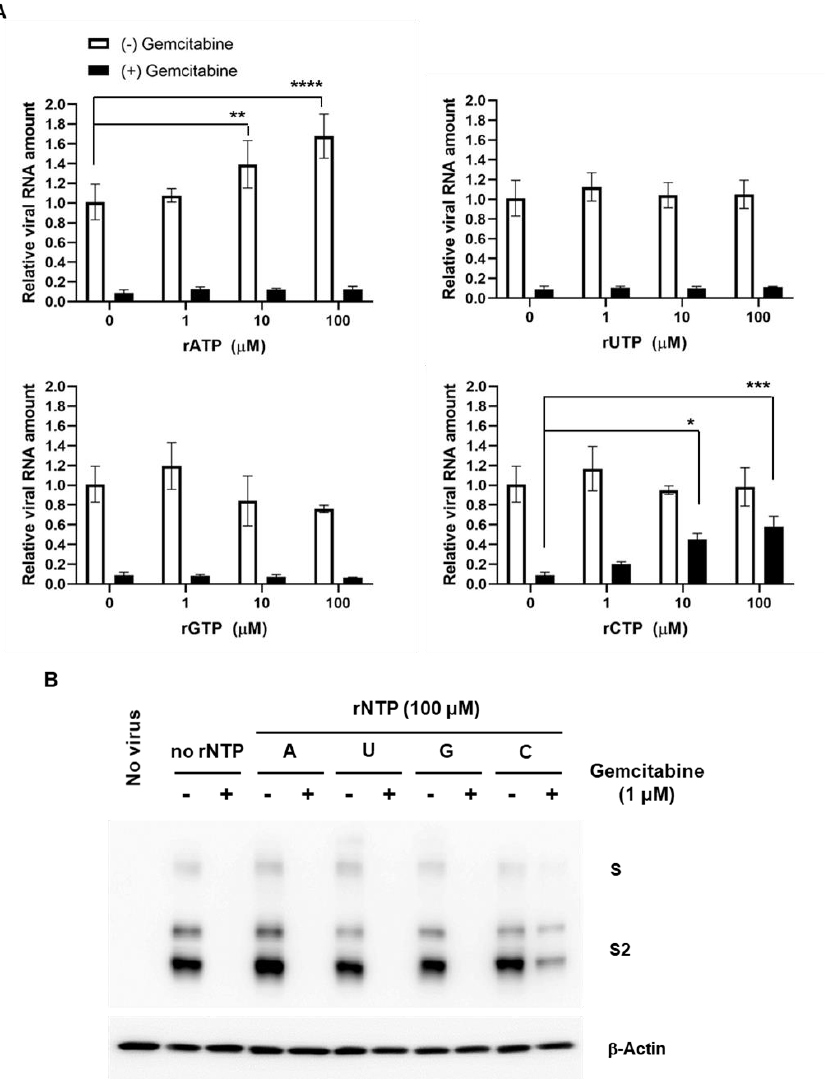
Figure 5. Competition assay between gemcitabine and each rNTP. ( A ) Real-time RT-PCR for measuring viral RNA amounts. Vero cells seeded in 6-well plates were infected with SARS-CoV-2 at an MOI of 0.001 and then treated with increasing concentrations of one of rNTPs including rATP, rUTP, rGTP and rCTP (1, 10, and 100 μM) in the absence (white bars) or presence of gemcitabine (1 μM; black bars) for 24 h. Culture supernatants were harvested for RT-PCR with primers specific for the viral N gene. Infected cells mock-treated or treated with gemcitabine only were used as positive (100%) and negative controls, respectively. Data represent means and standard deviations from three independent experiments. Multiple comparisons were performed between each test group and the rNTP-untreated controls by two-way ANOVA. * p < 0.05; ** p < 0.01; *** p < 0.001; **** p < 0.0001. ( B ) Western blot analysis for visualization of viral S protein. The cell lysates prepared for ( A ) with 100 μM rNPTs in the absence (−) or presence of 1 μM gemcitabine (+) were harvested for immunoblotting with anti-S antibody by using β-actin as a loading control. ‘No virus’ means a naive sample without SARS-CoV-2 infection.